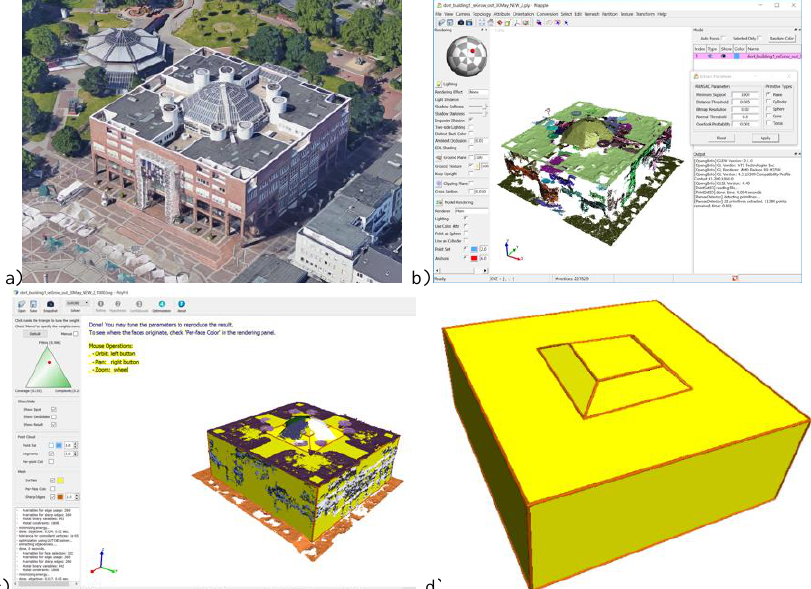
Figure 9: A building (City Hall) to be modelled from the dense point cloud (a); the Mapple tool with its parameter settings for